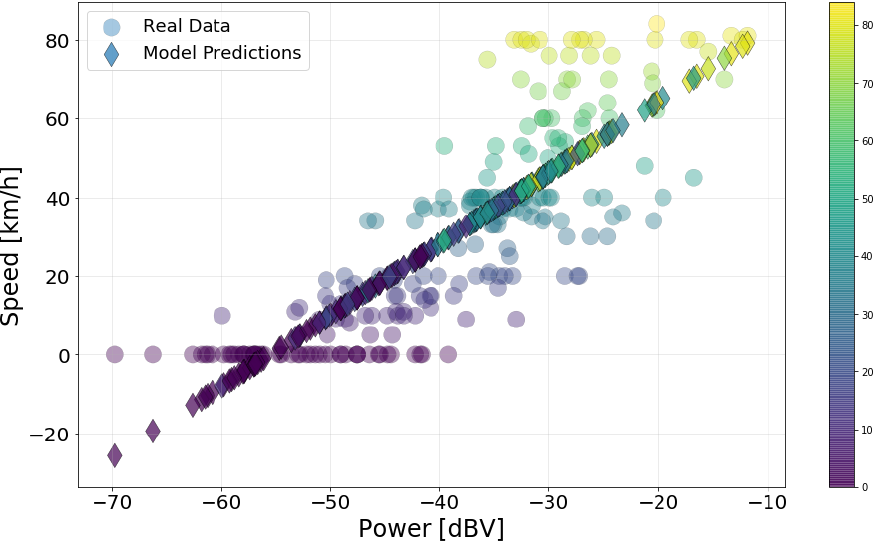
Figure 12. Histogram of the maximum speed of the car during the measurements.